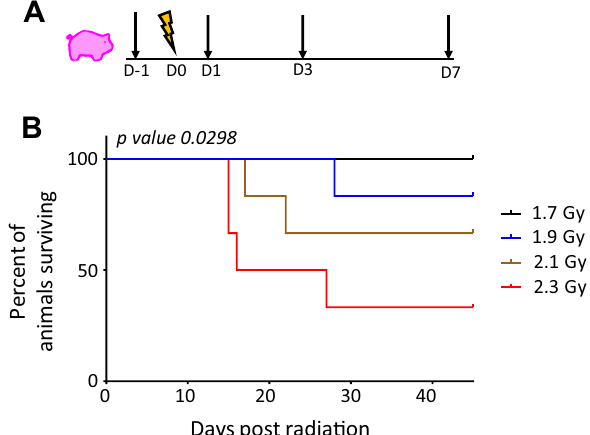
Figure 1. ( A ) Experimental design for blood collection for gene expression analysis. Blood was collected one day prior to irradiation (denoted as D-1); radiation day (D0), post irradiation collection 1 day (D1), 3 days (D3) and 7 days (D7) after radiation; ( B ) Kaplan Meier (K–M) Survival Curve for the animals studied. Time is plotted along x-axis and percent survival along y-axis; plot was generated in GraphPad